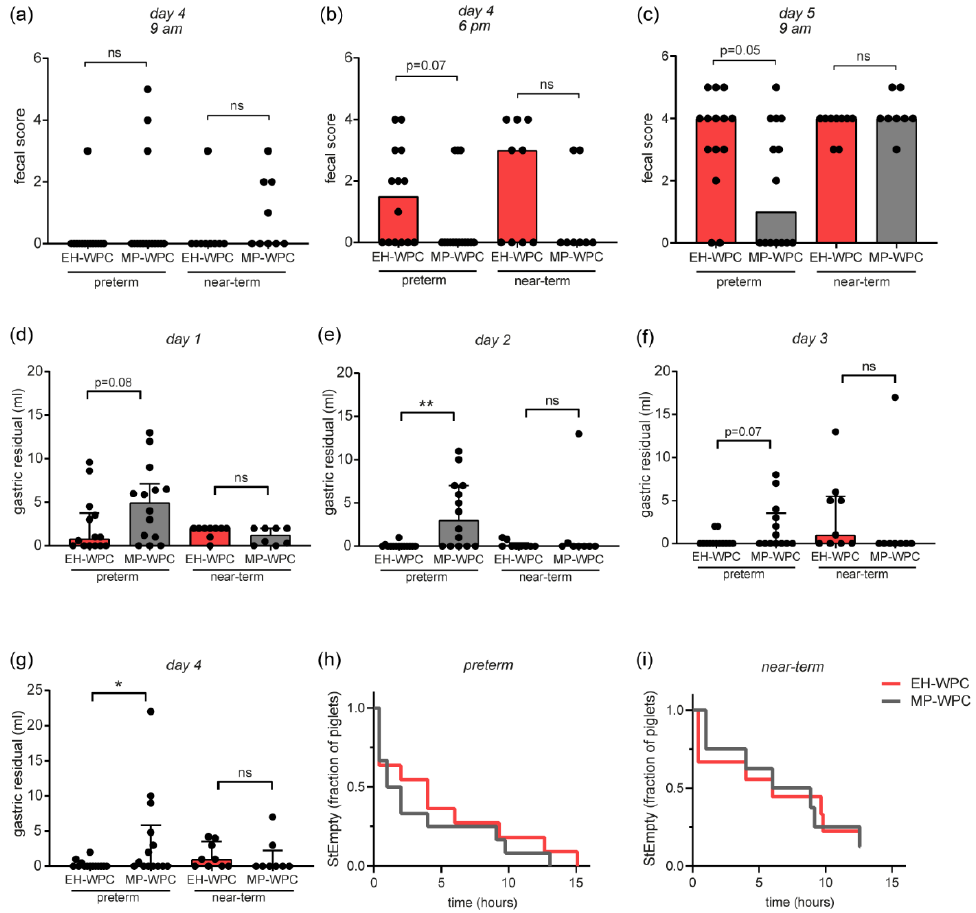
Figure 2. Clinical observations piglet study. ( a – c ) Fecal scores of preterm and near-term piglets at ( a ) day 4 at 9 am, ( b ) day 4 at 6 p.m. and ( c ) day 5 at 9 am. ( d – g ) Gastric aspirates were taken 3 h after a